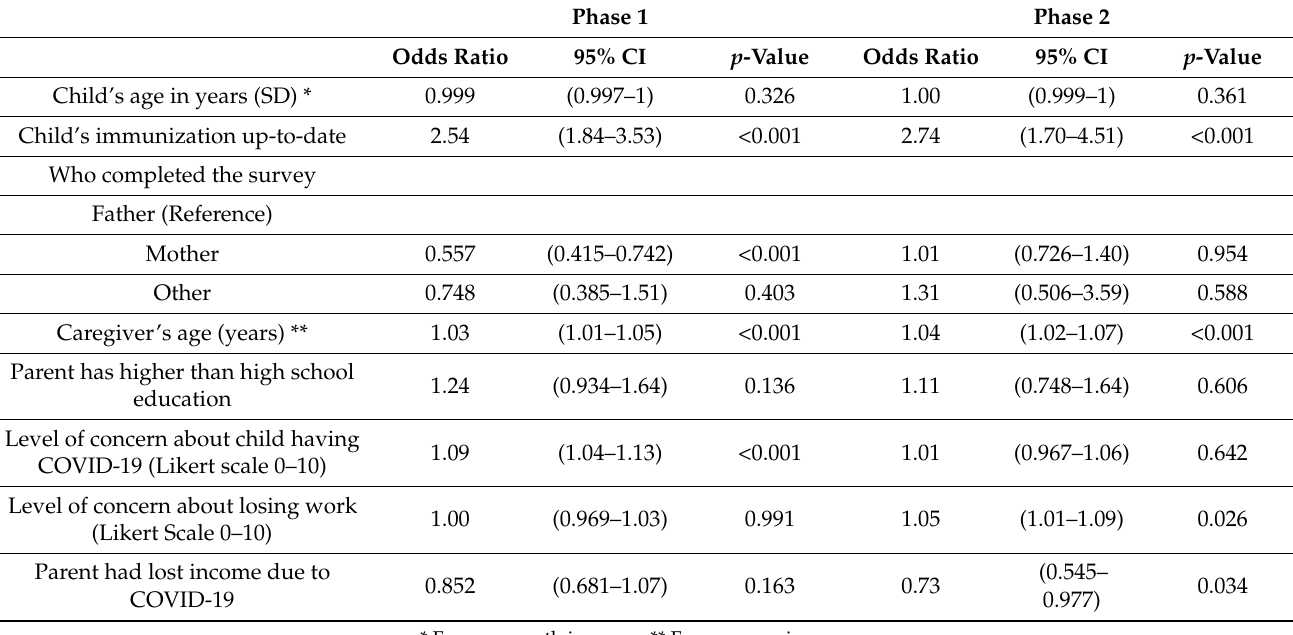
Table 3. Predictors of all caregivers’ willingness to vaccinate their children against COVID-19 identified by multivariable logistic regression analysis in first phase (March–May 2020) and second phase (December 2020–March